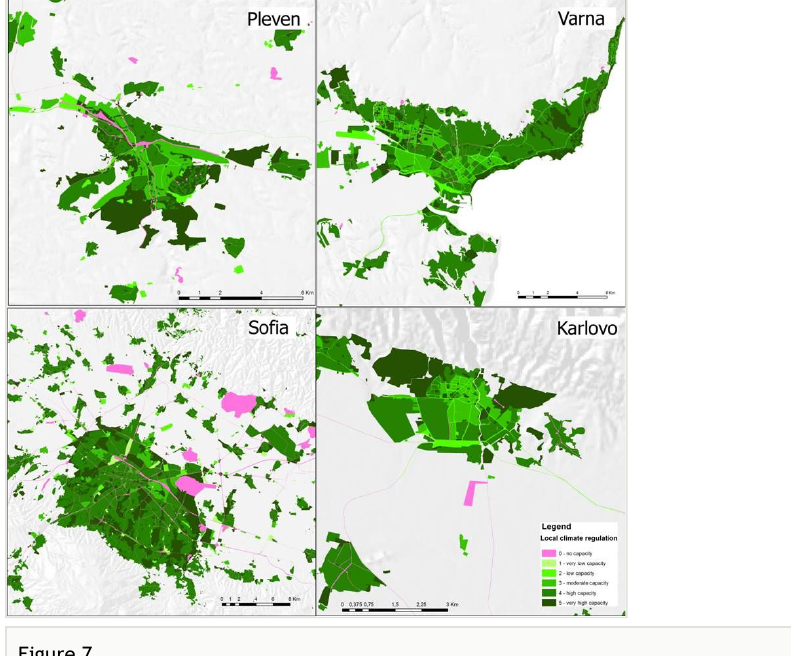
Figure 7. Maps of local climate regulation in selected